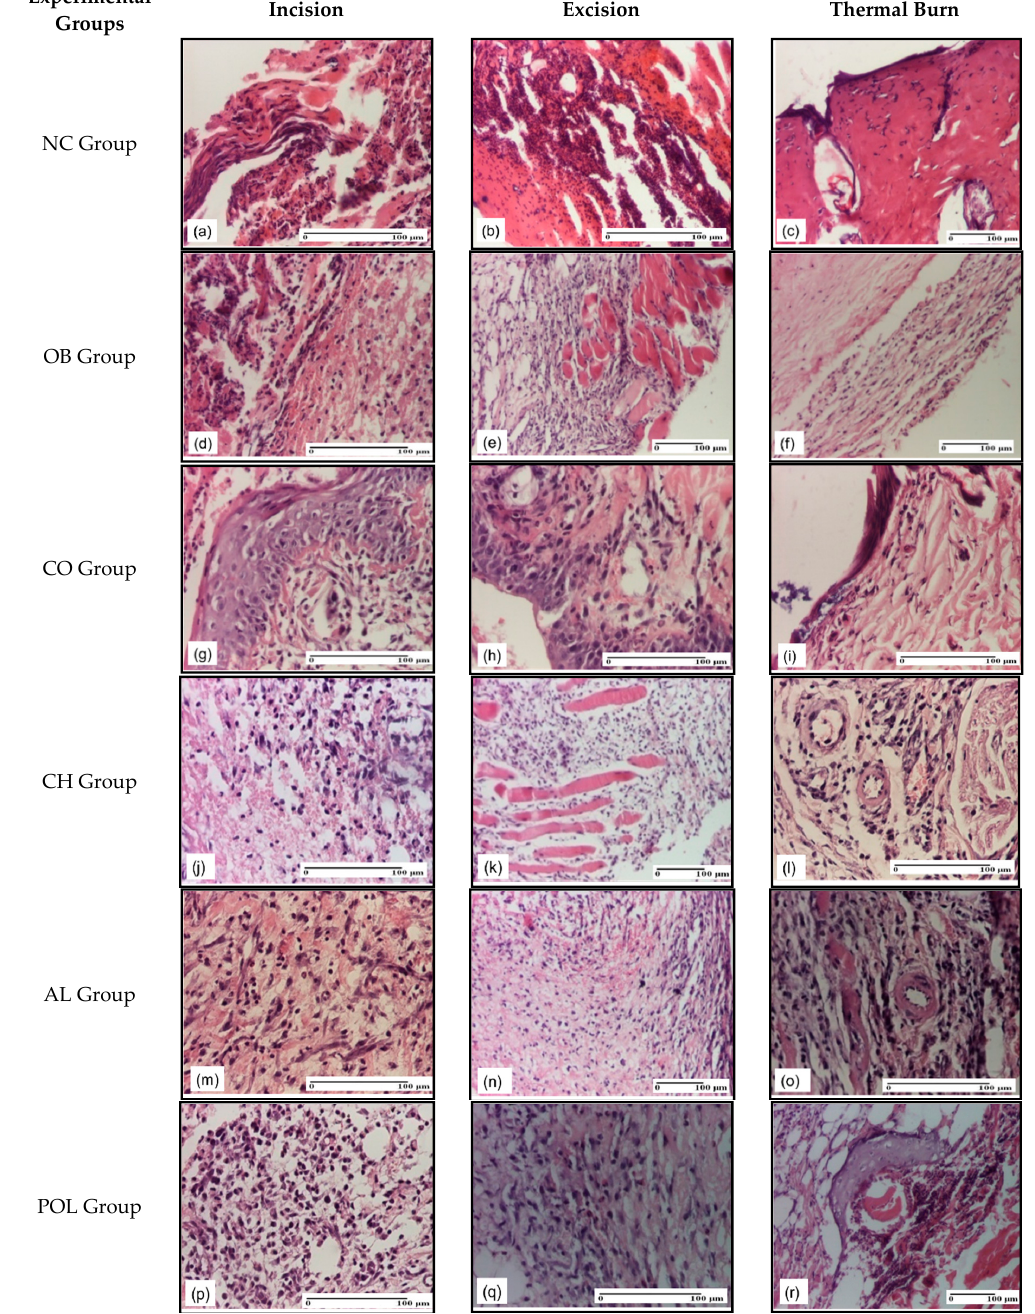
Figure 6. Microscopic histology images on day 3: ( a ) Abscess in keratin layer (S3); ( b ) Ulcerated epidermis with inflammation in dermis and hypodermis (lymphocytic deposit) (S3); ( c ) Significant dermal collagenization (S1, D1); ( d ) Congestion and inflammatory infiltrate in dermis (S3); ( e ) Inflammation in hypodermis, muscular layer (S3); ( f ) Inflammation (S2, D3); ( g ) Inflam- matory infiltrate (S2); ( h ) Areas of regenerated epidermis, inflammation in hypodermis (S2); ( i ) Perivascular lymphocytes (S1, D1); ( j ) Inflammation in dermis (S2); ( k ) Important inflammation (S3); ( l ) Inflammation in hypodermis (S2, D1); ( m ) Granulation tissue undergoing connective organization, lymphocytes (S1); ( n ) Granulation tissue with inflammatory infiltrate in hypodermis (S2); ( o ) Inflammatory infiltrate (S2, D1); ( p ) Important inflammatory infiltrate in hypodermis (S3); ( q ) Granulation tissue (S2); ( r ) Perivascular inflammatory infiltrate (S2, D2); Inflammatory infiltration scoring: S0 (no inflammatory infiltrate), S1 (mild inflammatory infiltrate), S2 (moderate inflammatory infiltrate), S3 (severe inflammatory infiltrate); The thermal burn depths (D): D0–normal skin, D1–epithelial necrosis within the epidermis, the basement membrane remains intact, D2–necrosis of skin appendages and dermal connective tissue; D3—extensive necrosis within the hypodermic